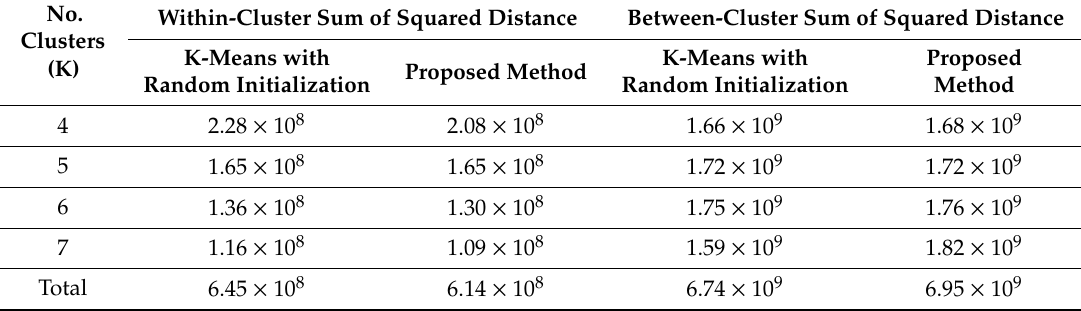
Table 3. Comparison of K-means clustering with random initialization and proposed